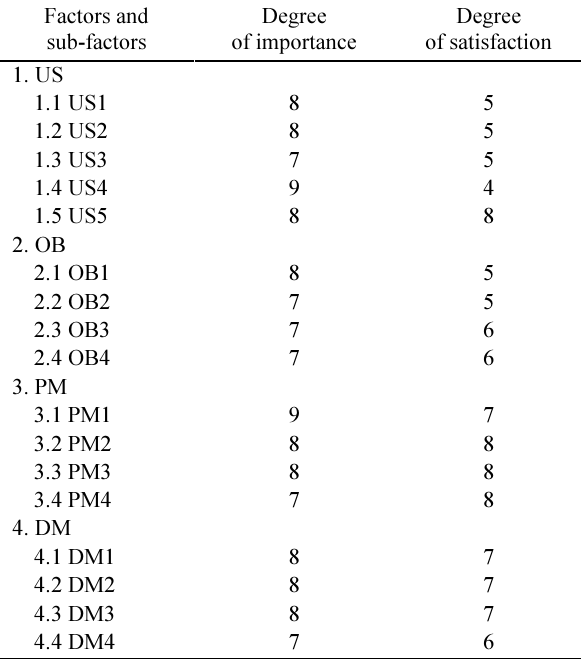
Table 3. Example of the response from the ISA questionnaire